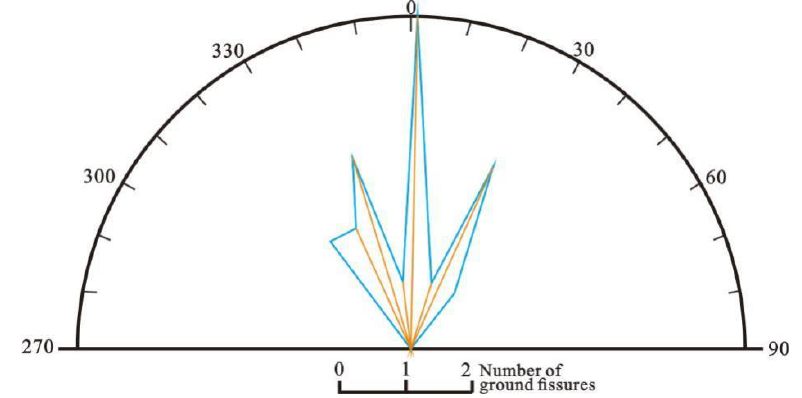
Figure 8. Rose diagram of ground fissure strikes.